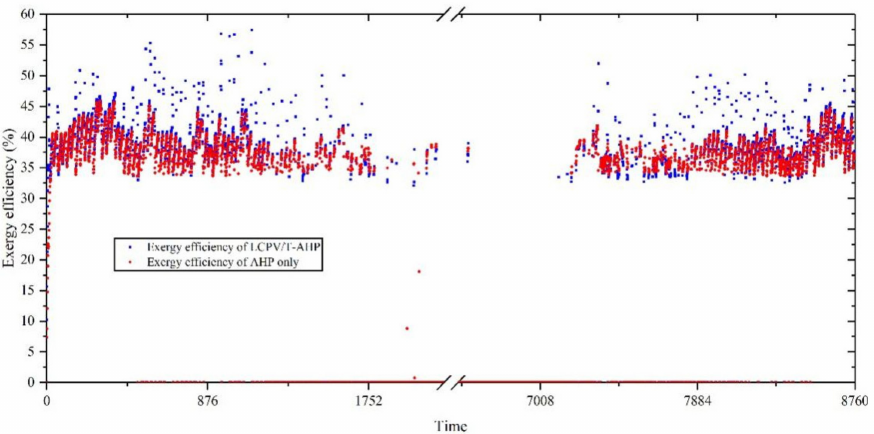
Figure 19. AHP exergy efficiency comparison between the LCPV/T-AHP system and the AHP only